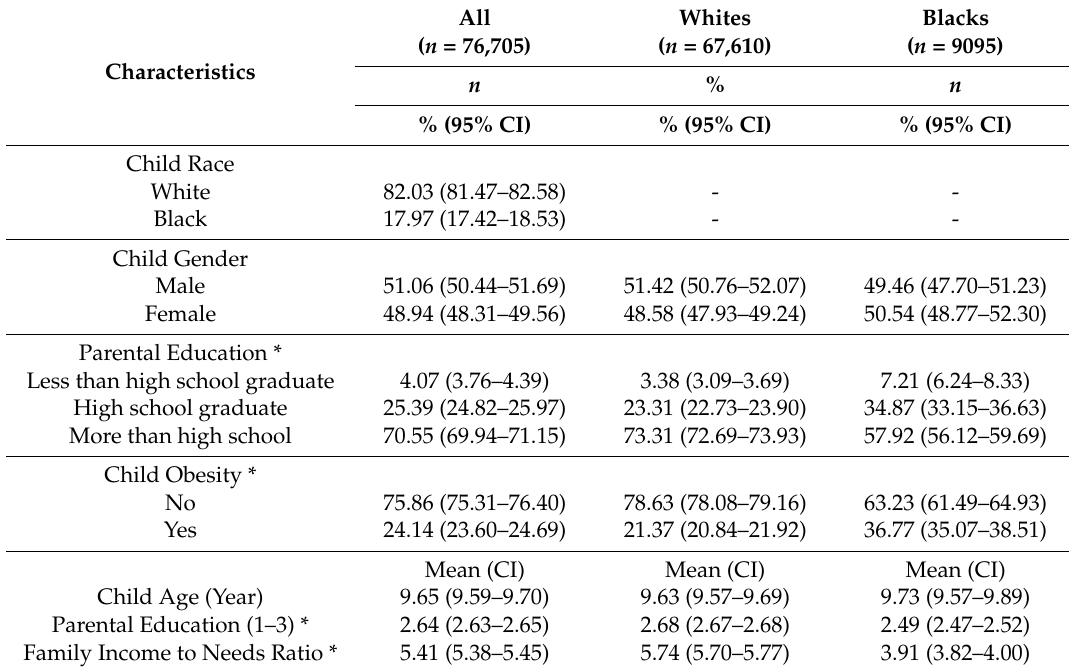
Table 1. Descriptive statistics in the pooled sample and by race.